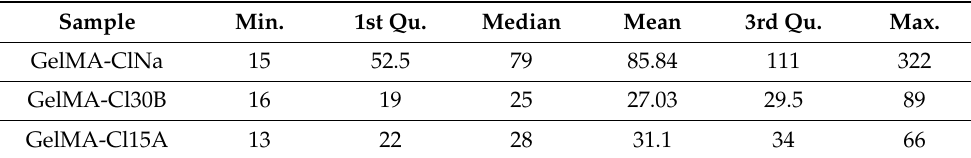
Table 3. Summary of data obtained by measuring the interlamellar distance in BF-TEM images (values are given in